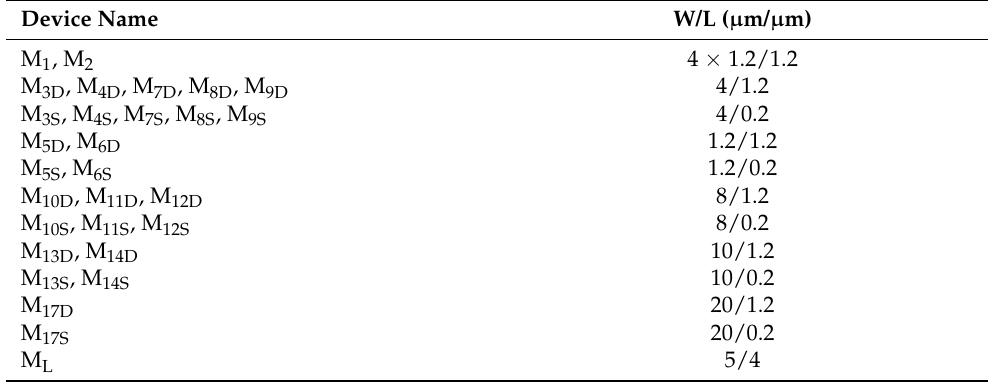
Table 1. Transistor aspect ratio of the MI-OTA.